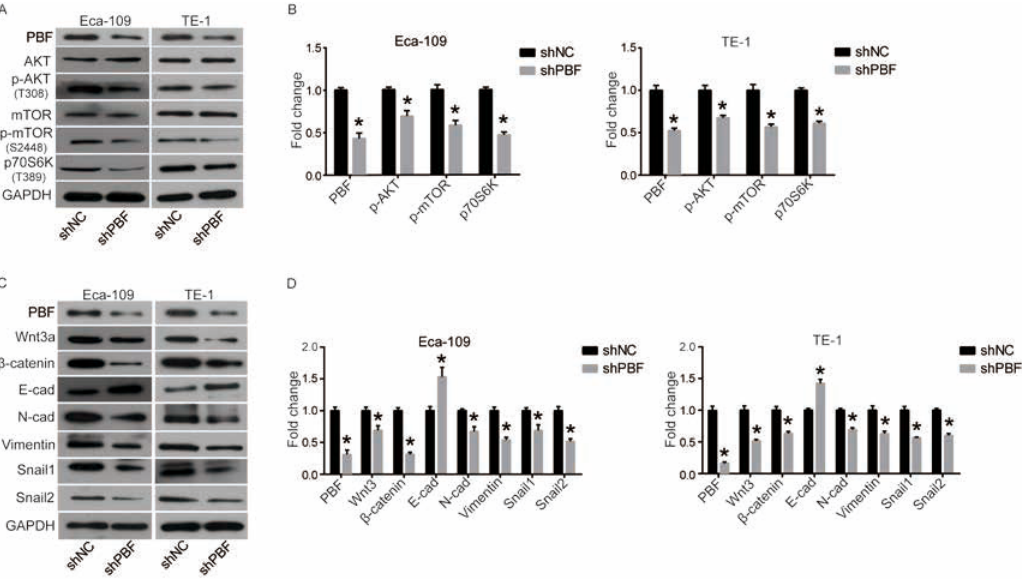
Figure 5: Down-regulation of PBF inhibits the AKT/mTOR and Wnt/β-catenin signaling pathways. (A) and (B) AKT/mTOR pathway including AKT, p-AKT, mTOR, p-mTOR and p-p70S6K was detected by western blot and quantified in density by ImageJ software; (C) and (D) Wnt/β- catenin pathway including Wnt3a, β-catenin, E-cad, N-cad, Vimentin, Snail1 and Snail2 was detected by western blot and quantified in density by ImageJ software. All experiments were repeated 3 times. *P represented significant Taken together, PBF knockdown-induced cell phe- expression of cell movement-associated proteins, includ- notypic changes, including inhibition of proliferation, ing increased E-cad, decreased N-cad, Vimentin, Snail1 mobility and so on, may be mediated by the inactivation and Snail2, which indicated that EMT was activated (Fig. of AKT/mTOR and Wnt3a/β-catenin pathways. 5C and D).